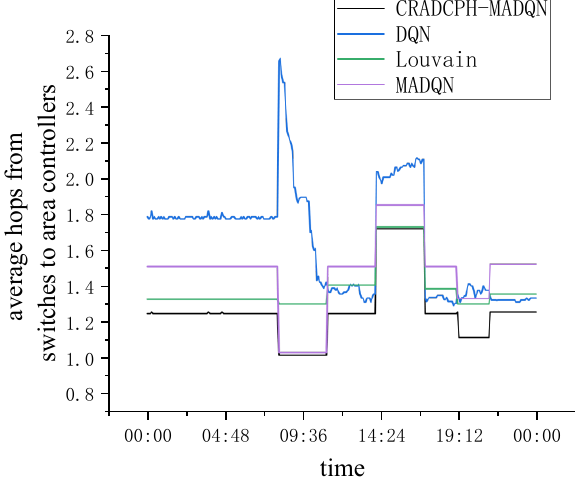
Figure 6. Average